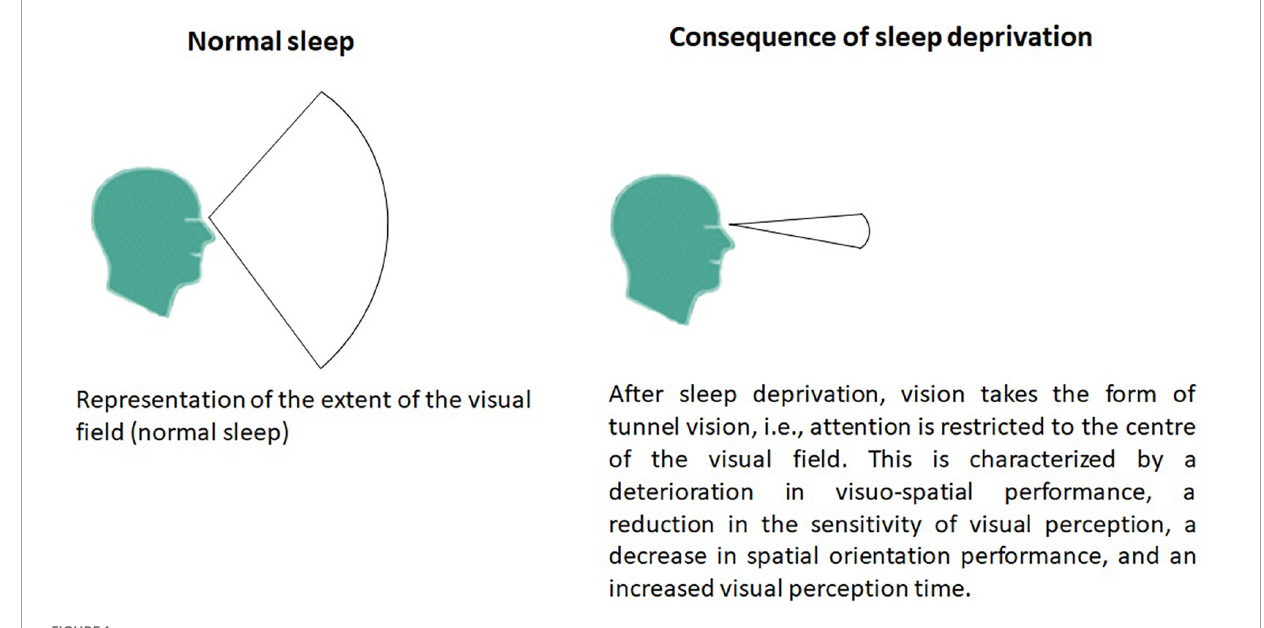
FIGURE1 Representation of the visual field without and with (consequence) sleep